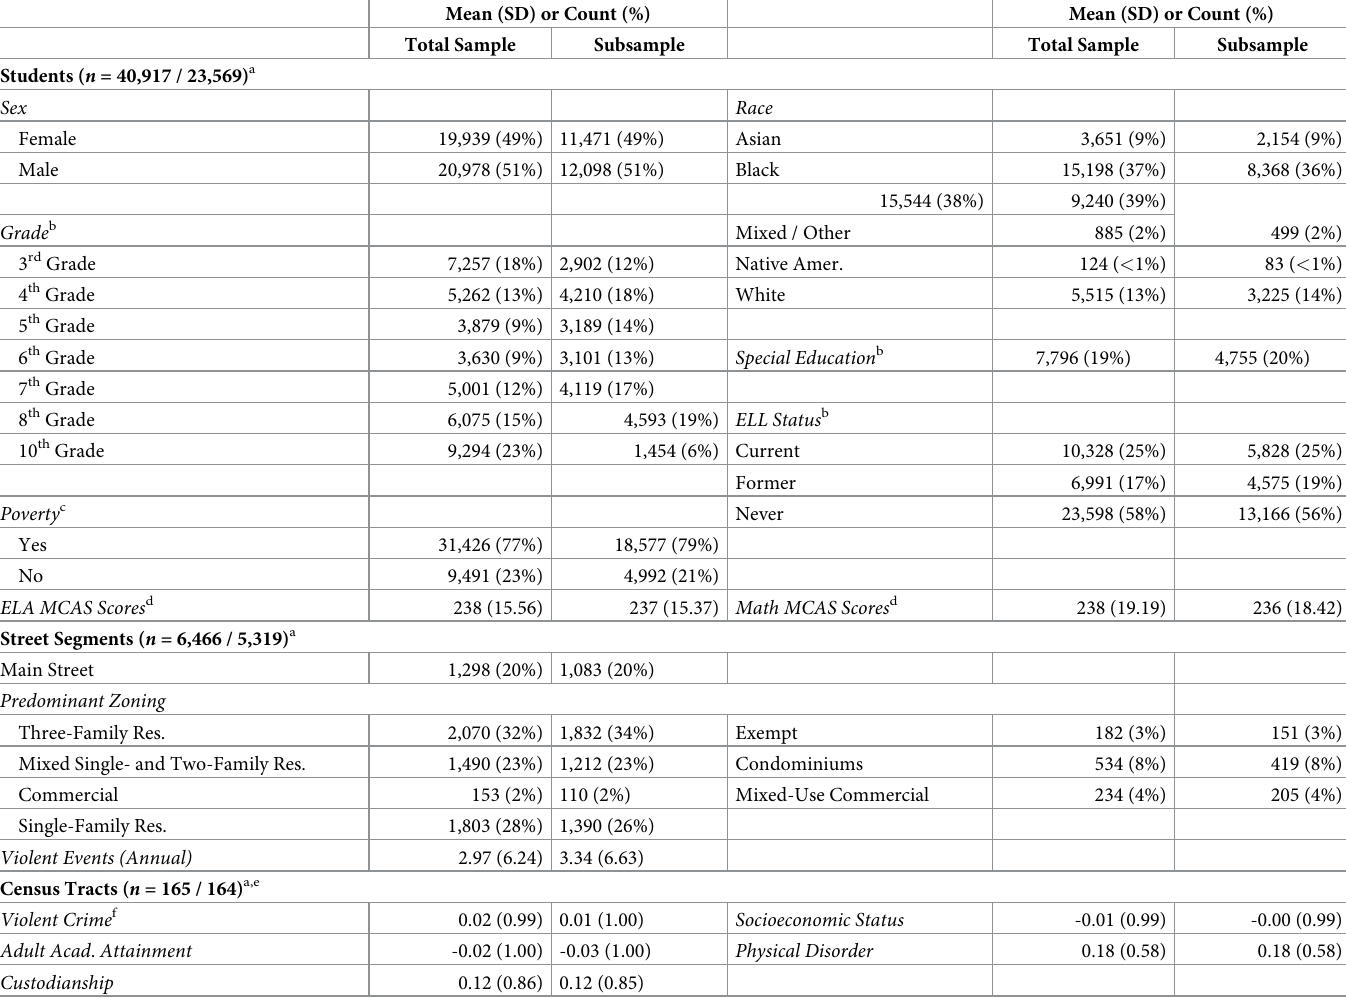
Table 1. Characteristics of students, streets, and tracts for the total sample and the subsample of students included in the fixed effects